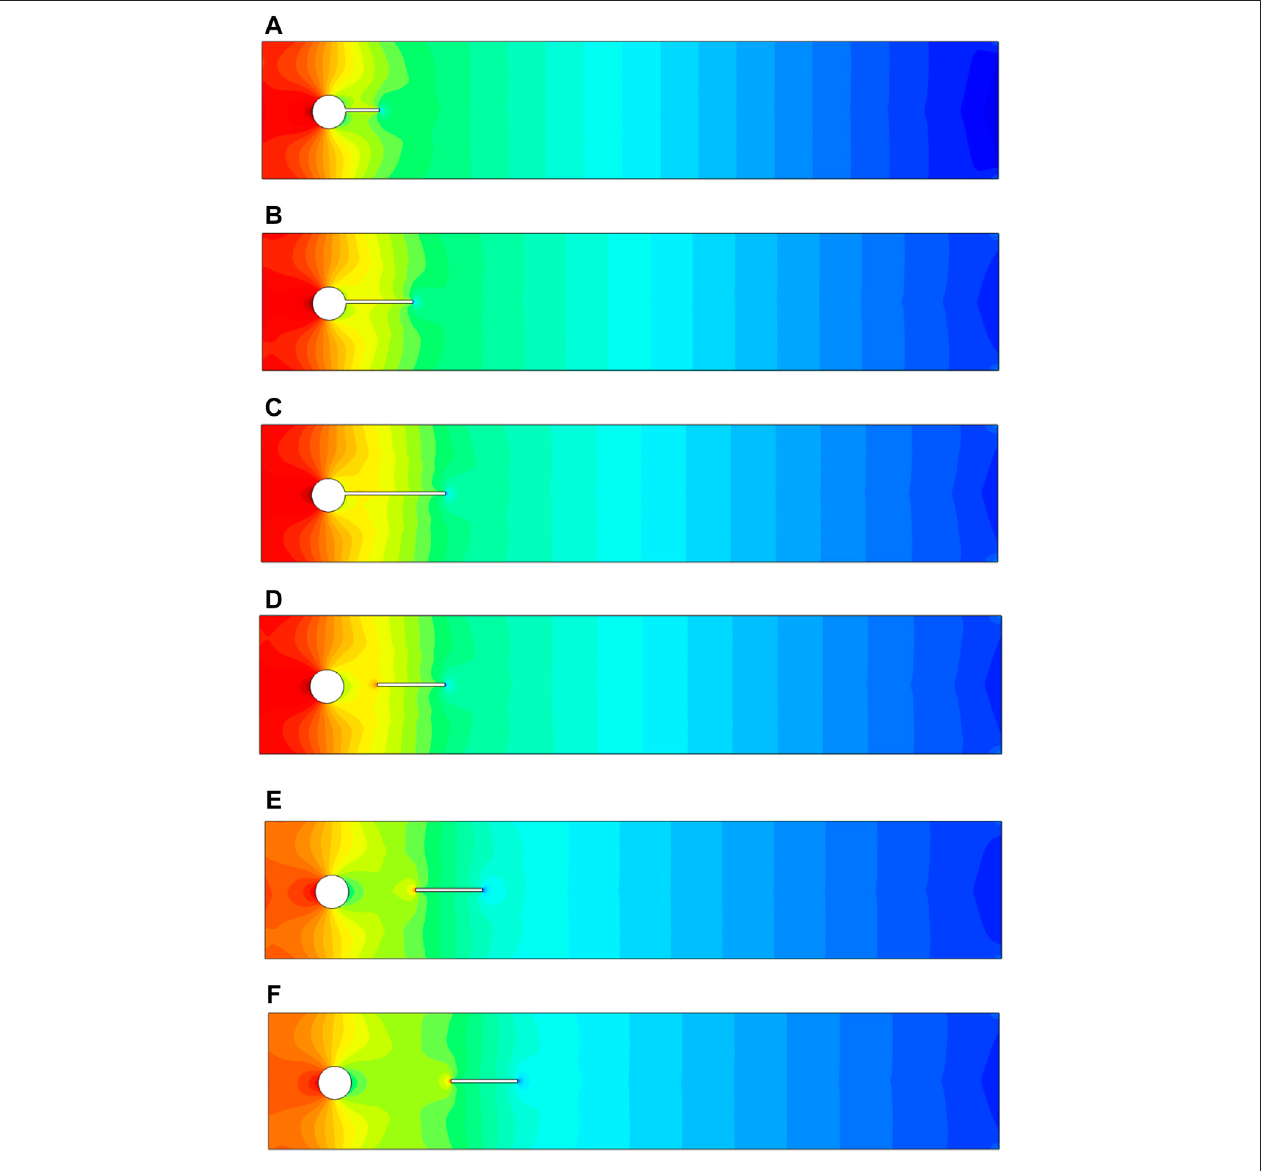
FIGURE 14 | In fl uence of an attached splitter plate of length (A) L 1 = 0.1, (B) L 2 = 0.2, (C) L 3 = 0.3 and gap separation (D) G 1 = 0.1, (E) G 2 = 0.2, (F) G 3 = 0.3 on pressure, at (cid:2) t (cid:1) 10 .